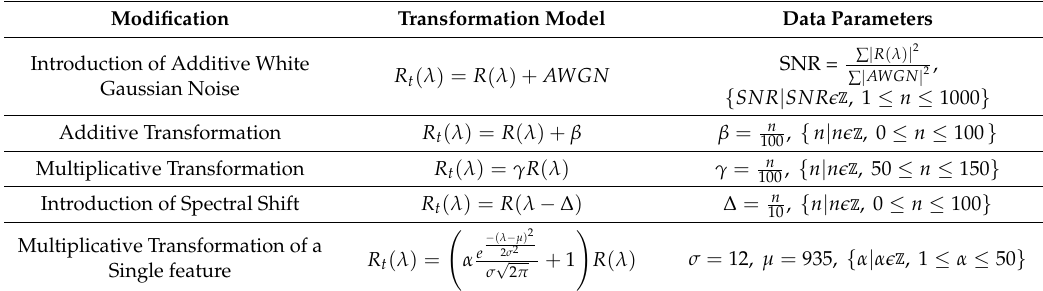
Table 1. The five modifications applied to R ( λ ) to generate the transformed signal, R t ( λ ) .